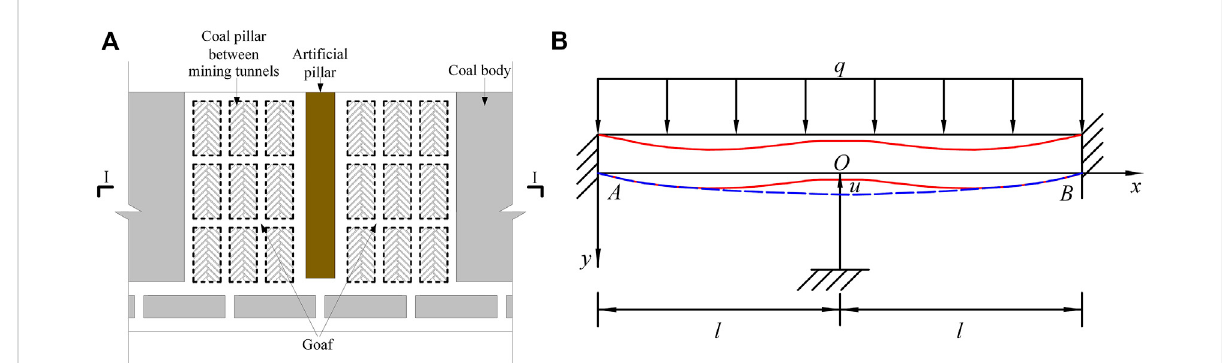
FIGURE 5 The goaf after block mining and the proposed mechanical model of the system. (A) The goaf after block mining; (B) mechanical model of the rock beam-arti fi cial pillar